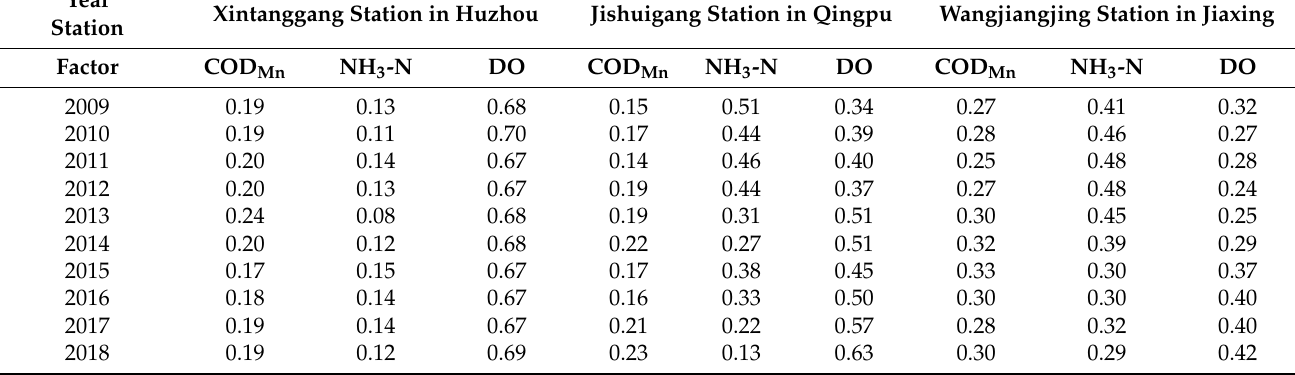
Table A3. Normalized results of water quality evaluation index weights.